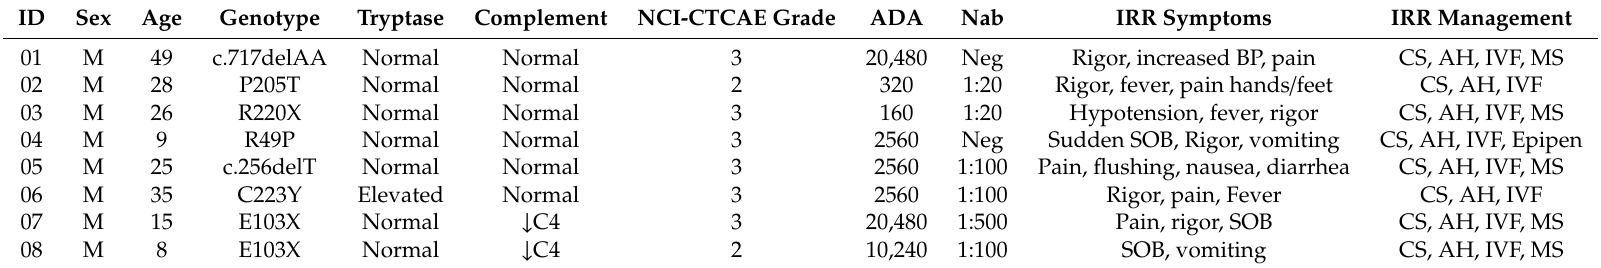
Table 1. Eight subjects with Fabry disease show infusion-related reactions (IRR) during enzyme replacement